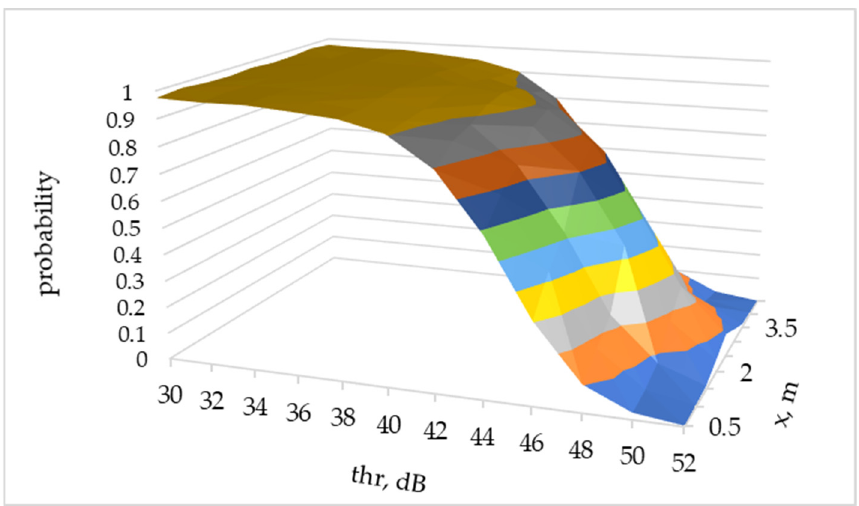
Figure 12. Dependence of POD vs. threshold value thr and crack’s coordinate x.